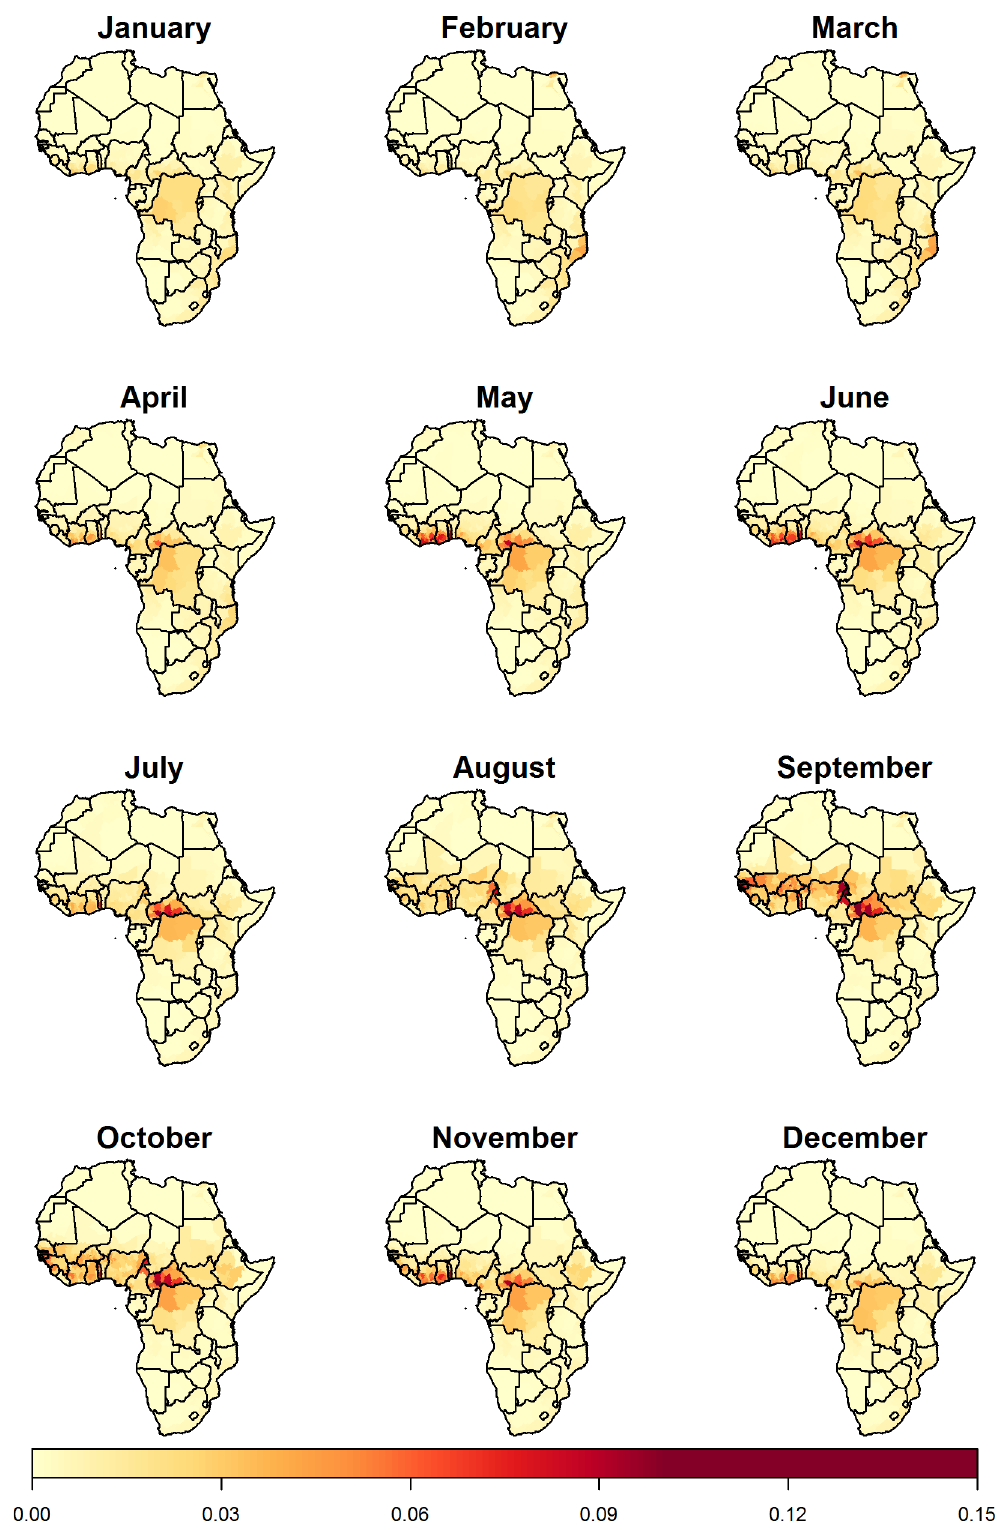
Fig 4. Seasonal model monthly predictions. Model predictions of the monthly YF report probabilities across Africa from the seasonal model. The AUC was 0.81 (0.78; 0.84).